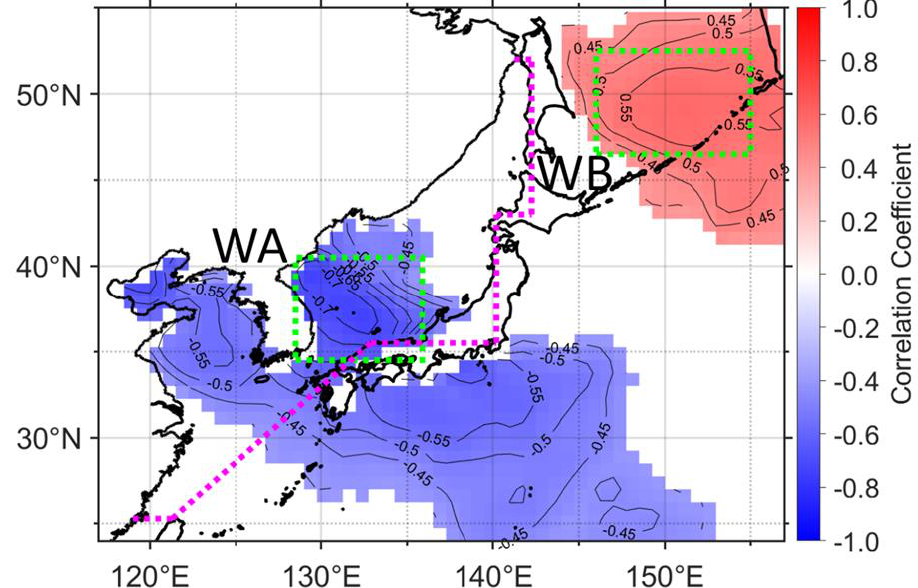
Figure 5. Correlation map of the NEAMS winter sea level with the surface wind stress anomaly in the southeast ( + )–northwest ( − ) direction from 1993 to 2017. The contour interval is 0.05 and correlations with less than 95% significances were discarded. A positive correlation means that a high (low) NEAMS sea level occurs with a strong southeastward (northwestward) wind stress anomaly. Here, the areas showing the maximum positive (WB) and negative (WA) correlation coe ffi cients are marked with green dotted boxes and the NEAMS is indicated with magenta dotted lines.